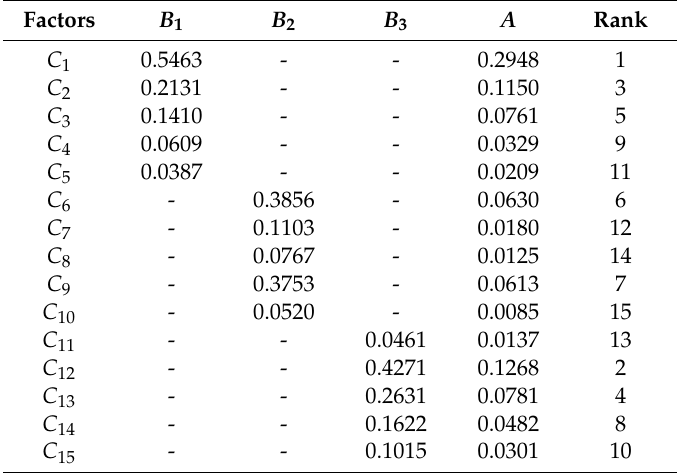
Table 3. Factors’ weights and